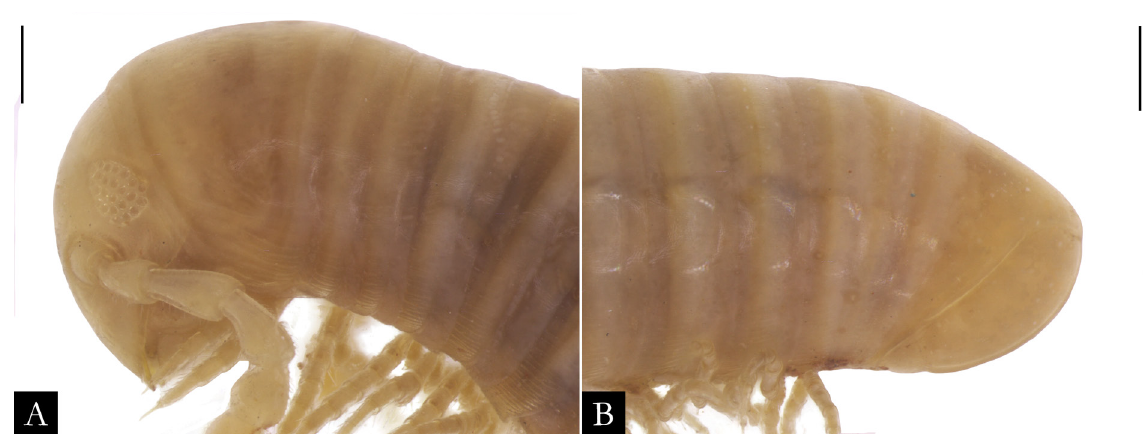
Fig. 101. Pseudonannolene ophiiulus Schubart, 1944, ♂ (MZSP 1061), in lateral view. A . Anterior region. B . Posterior region. Scale bars = 0.5